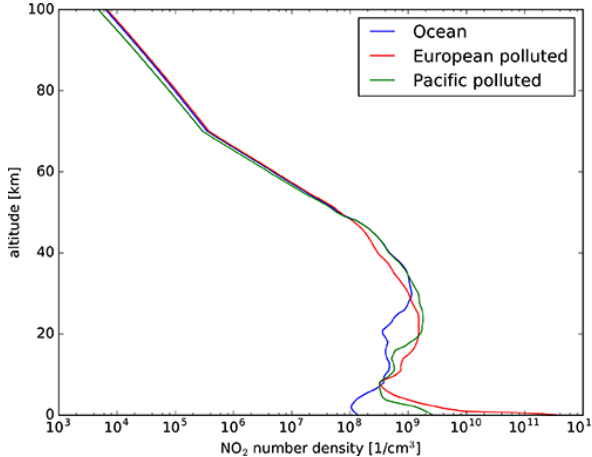
Figure 1. NO 2 number concentration profiles for typical scenarios taken from the CAMELOT study (Levelt et al.,